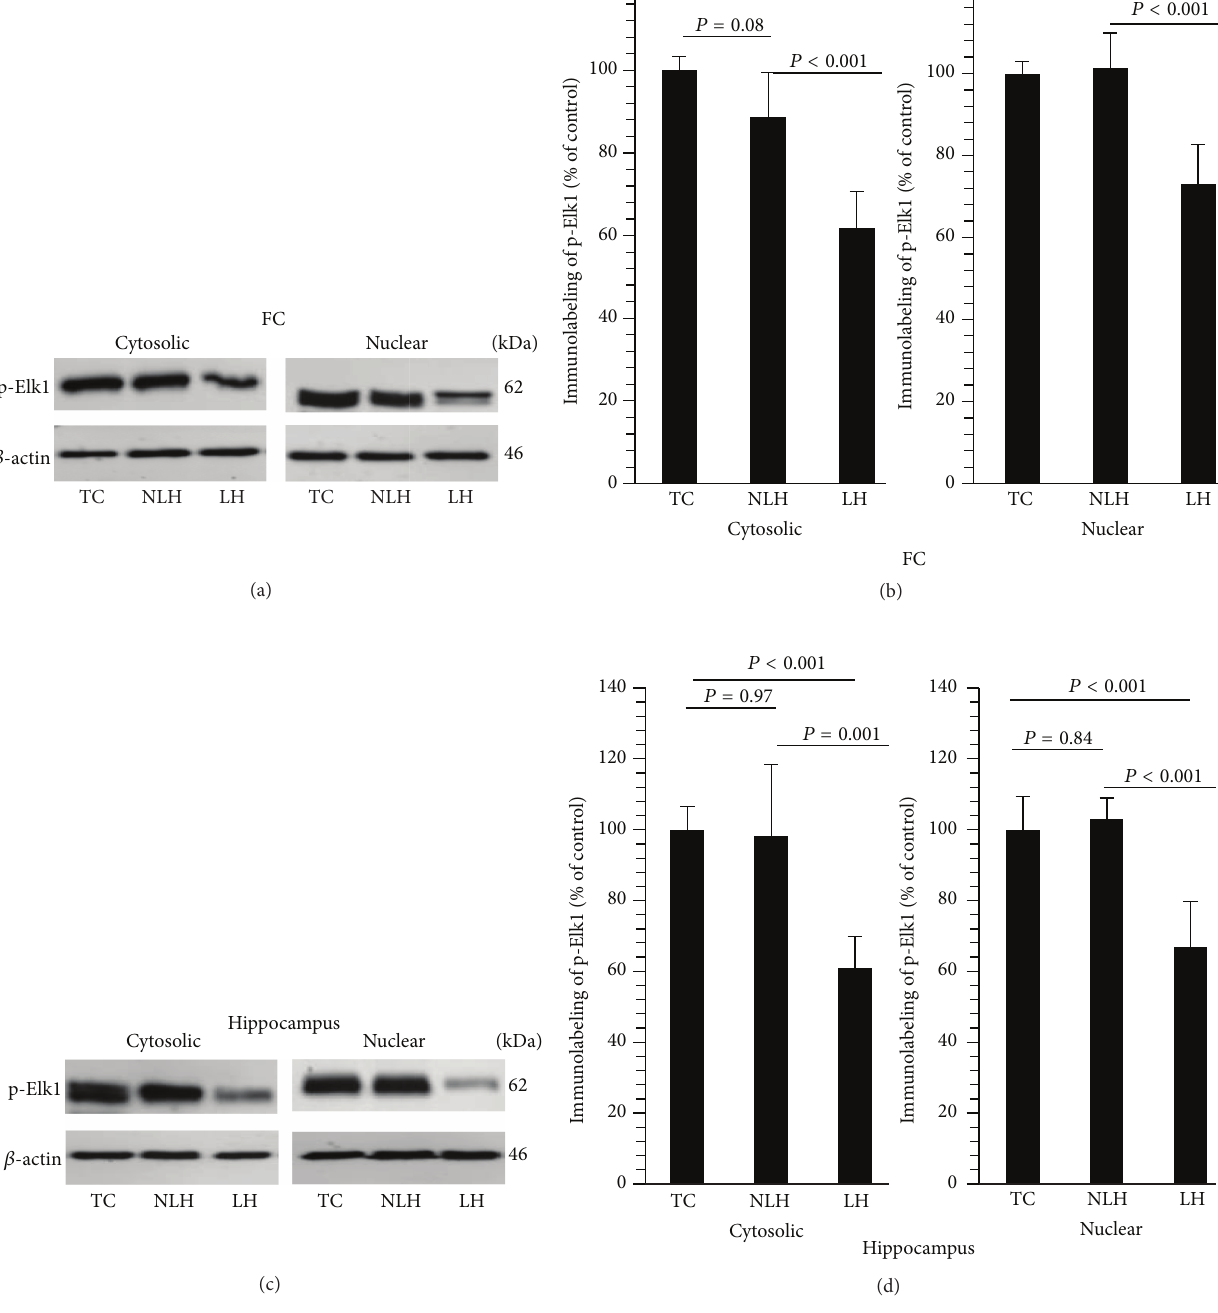
Figure 5: Catalytic activities of ERK1/2 (represented as ERK1/2-mediated phosphorylation of Elk1) in cytosolic and nuclear fractions of FC (a) and hippocampus (c) obtained from TC (tested controls), non-learned helpless (non-LH), and learned helpless (LH) rats. 𝛽 -actin was used as normalizer. Mean ± SD of Elk1 phosphorylation in cytosolic and nuclear fractions of FC (b) and hippocampus (d) of TC, non-LH, and LH rats ( 𝑛 = 6 /group). Overall group differences among TC, non-LH, and LH rats are as follows. FC: cytosolic, df = 2, 15 , 𝐹 = 33.71 , and 𝑃 < 0.001 ; nuclear, df = 2,15 , 𝐹 = 25.93 , and 𝑃 < 0.001 . Hippocampus: cytosolic, df = 2, 15 , 𝐹 = 16.63 , and 𝑃 < 0.001 ; nuclear, df = 2,15 , 𝐹 = 25.57 , and 𝑃 < 0.001